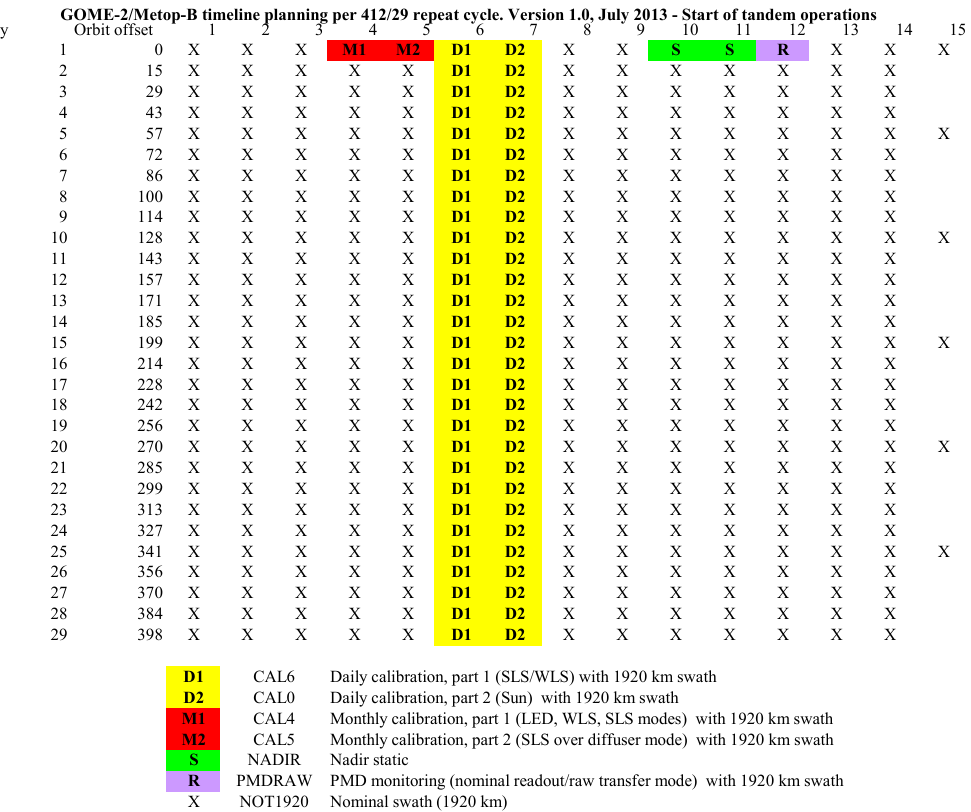
Figure 4. The 29-day instrument operation cycle of GOME-2 on Metop-B. Different colours and ID tags indicate different instrument operations settings as explained in the legend.